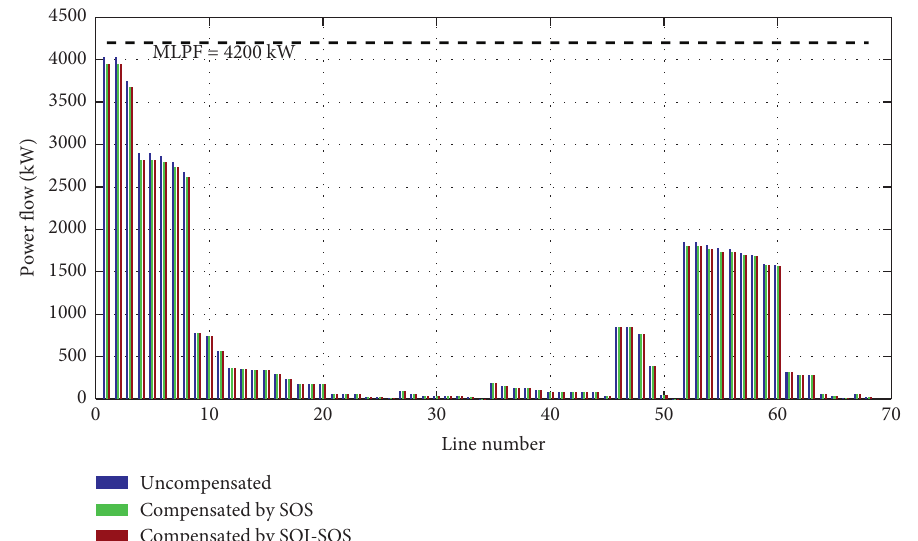
Figure 11: Comparison of lines power flow of the 69-bus system before and after compensation with the CP load model at 100%